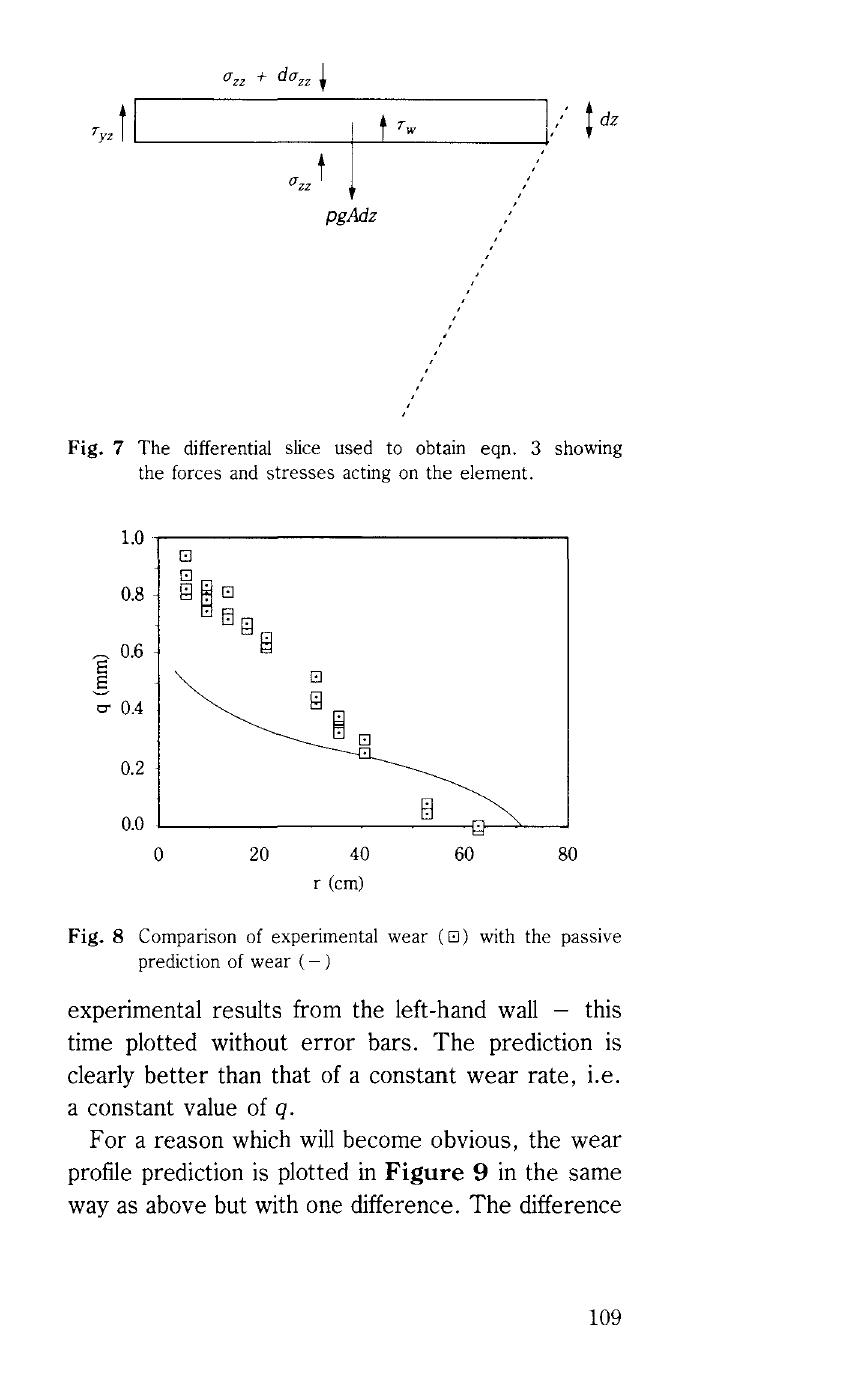
Fig. 8 Comparison of experimental wear ( 0) with the passive prediction of wear ( - ) experimental results from the left-hand wall - this time plotted without error bars. The prediction is clearly better than that of a constant wear rate,